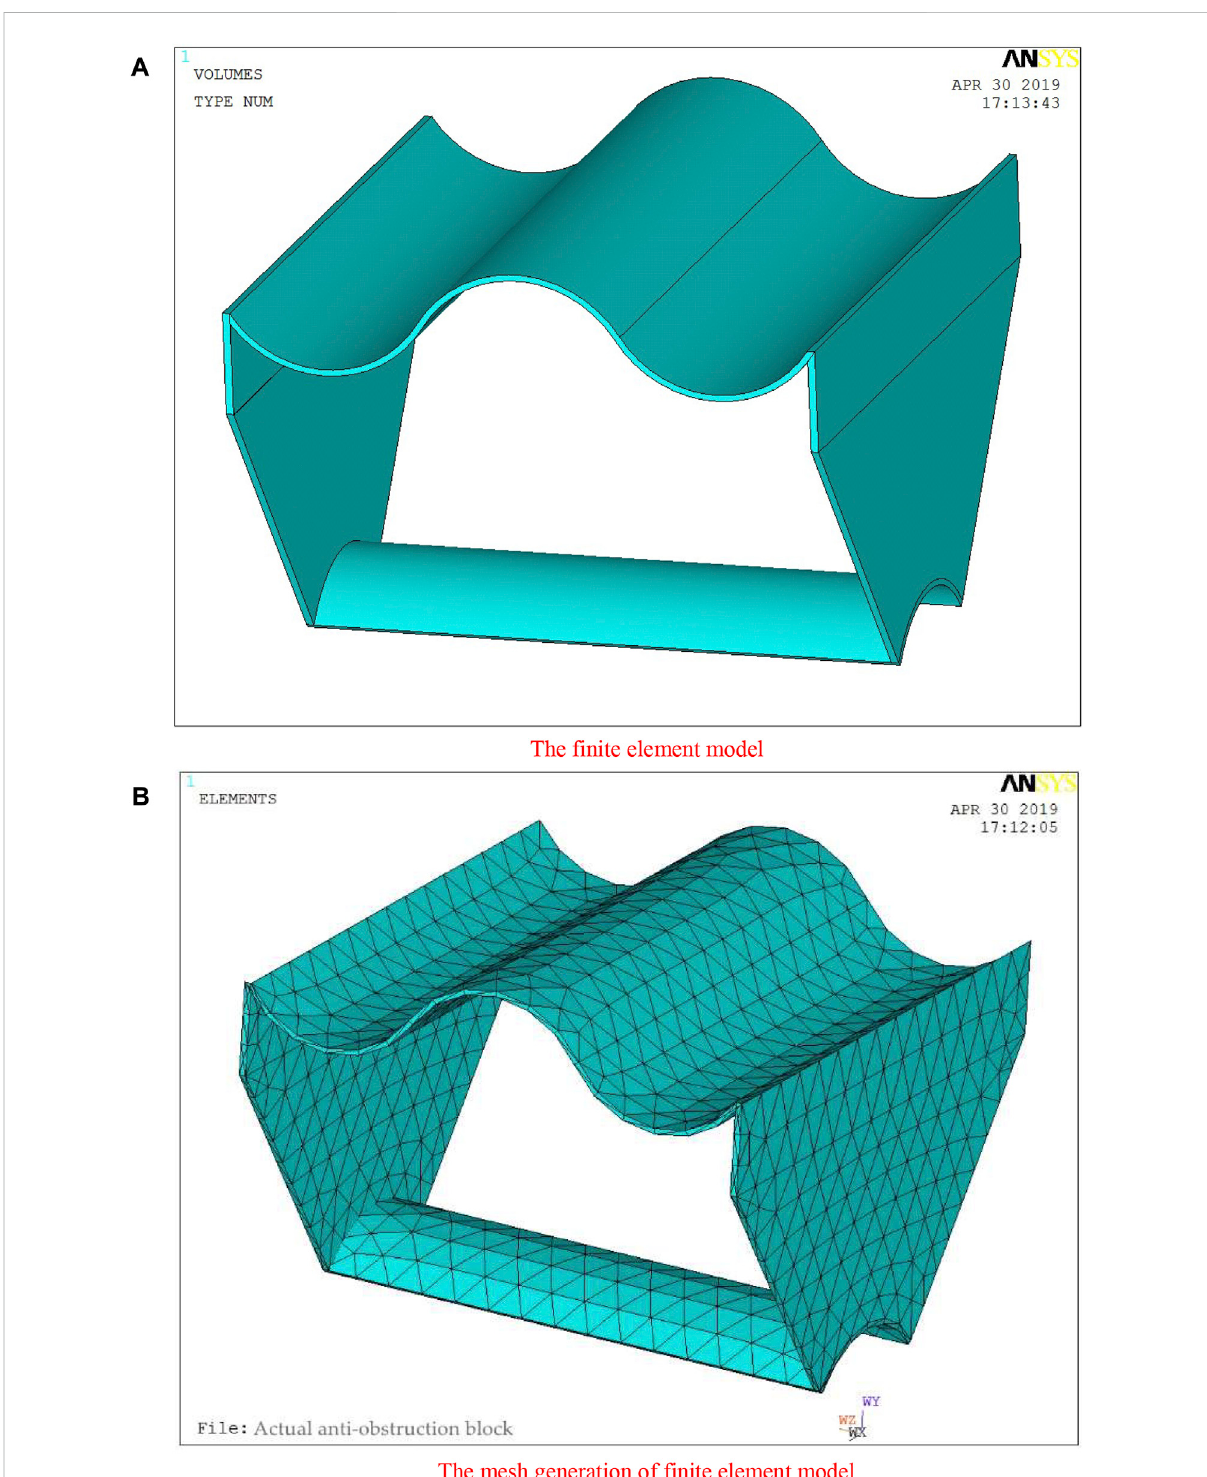
FIGURE 3 Finite element model and mesh generation of the anti-obstructionblock. (A) : Finite element model; (B) : The mesh generation of fi nite element